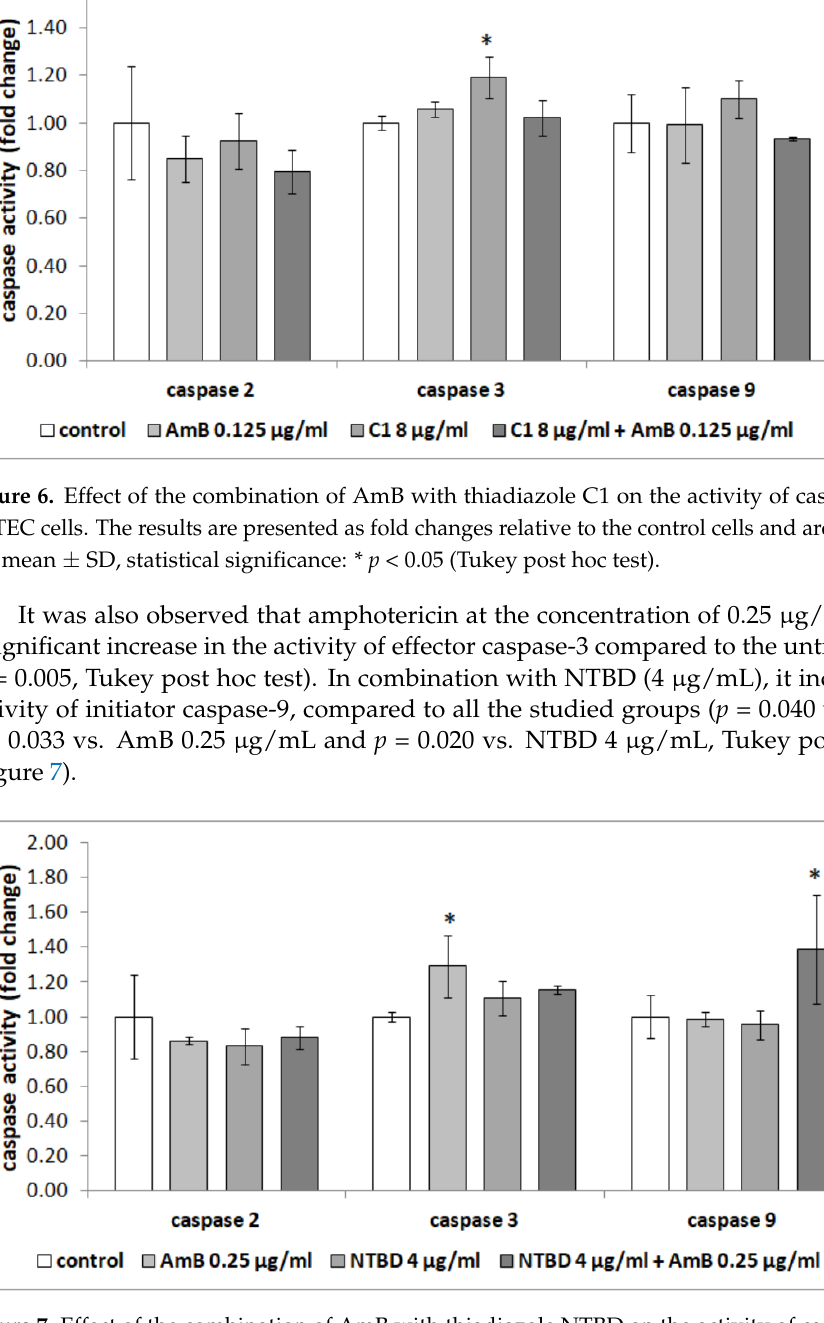
Figure 7. Effect of the combination of AmB with thiadiazole NTBD on the activity of caspases in the RPTECs. The results are presented as fold changes relative to the control cells and are reported as the mean ± SD, statistical significance: * p < 0.05 (Tukey post hoc